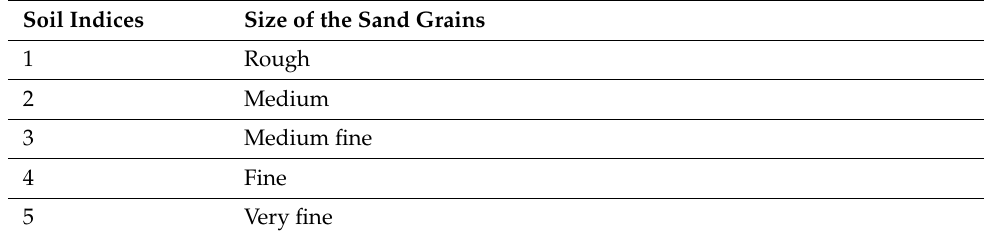
Figure 13. Climatology of soil types (4D-Var ERA5) from 1979 to 2008 with a resolution of 0.5 × 0.5 degrees. Data taken from the ERA5 platform. .